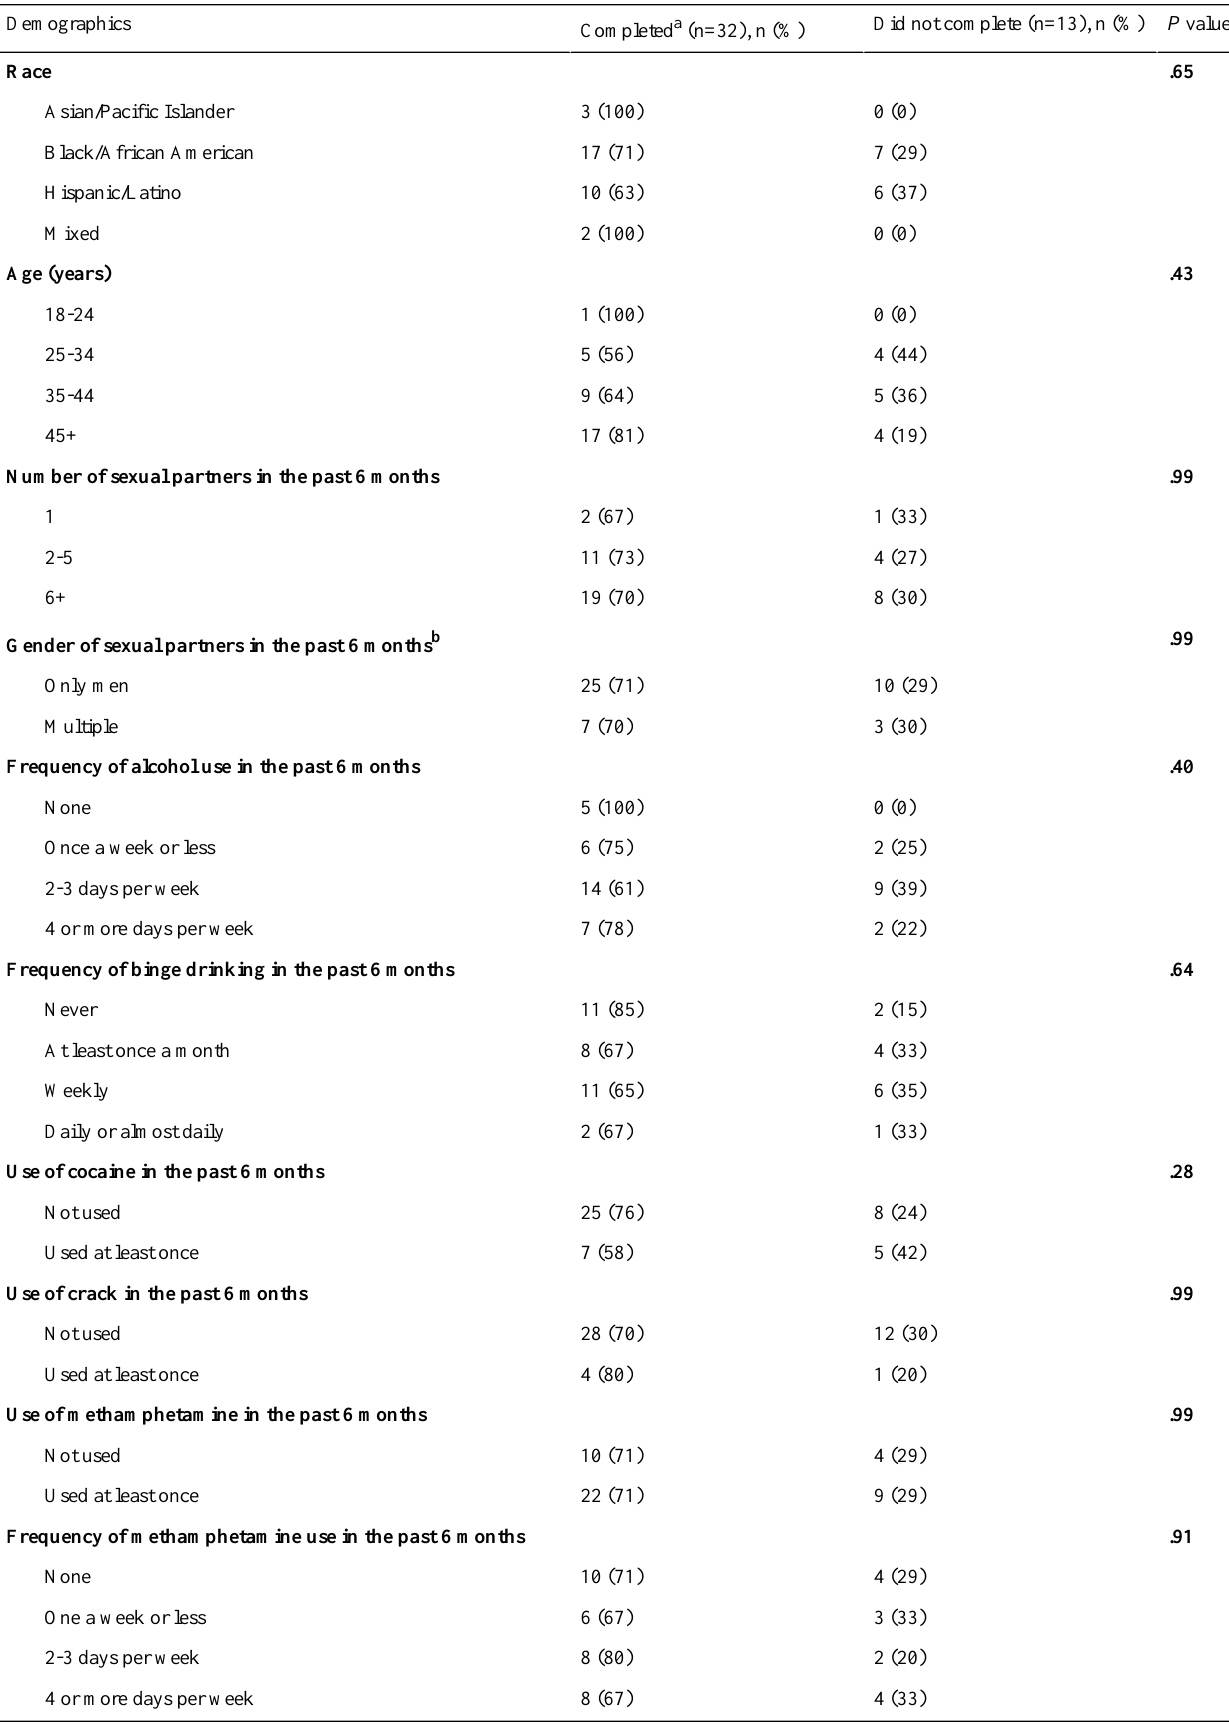
Table 2. Demographics of participants (n=45) based on the completion of all 7 text messaging